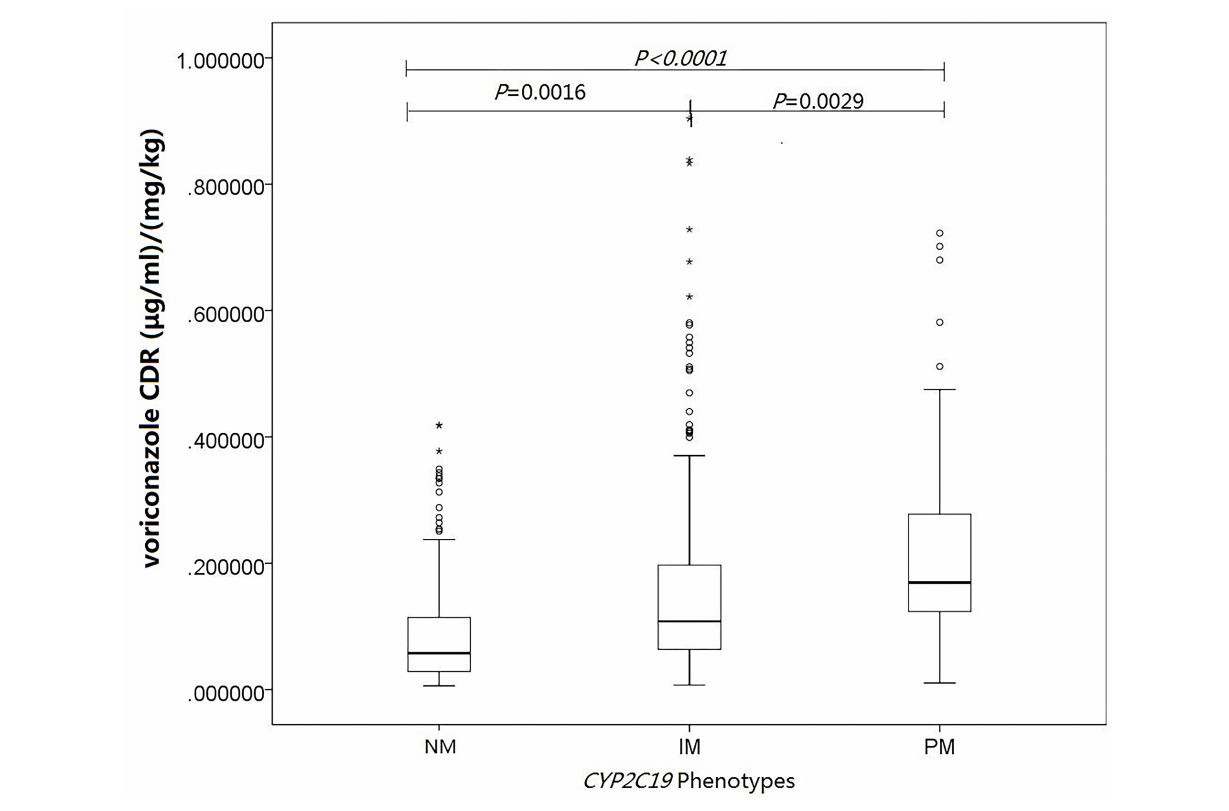
Frontiers in Pediatrics |